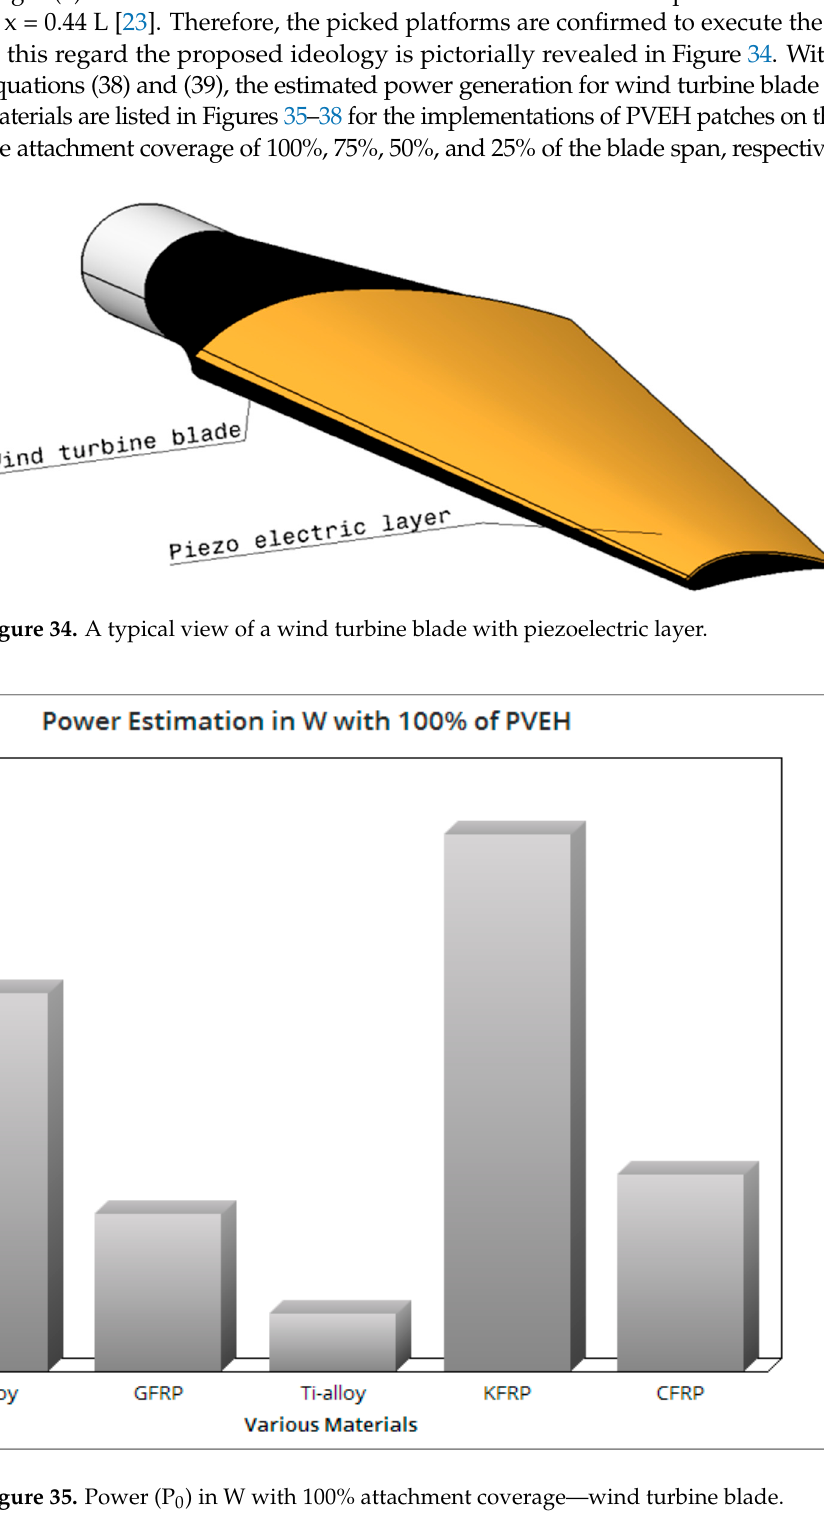
Figure 36. Power (P 0 ) in W with 75% attachment coverage—wind turbine blade.